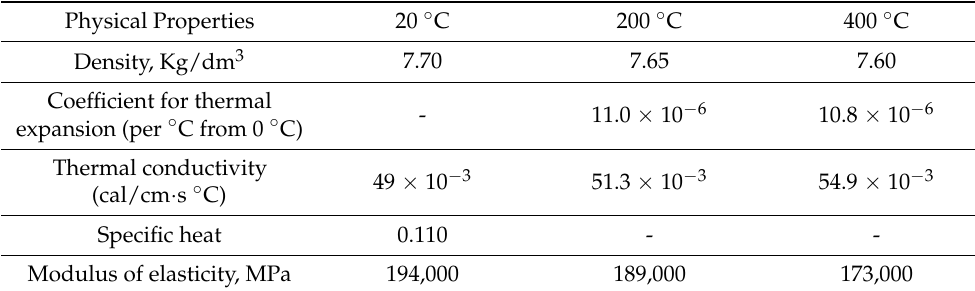
Table 2. The physical properties of the steel used to make the trimming dies X210Cr12 [20].